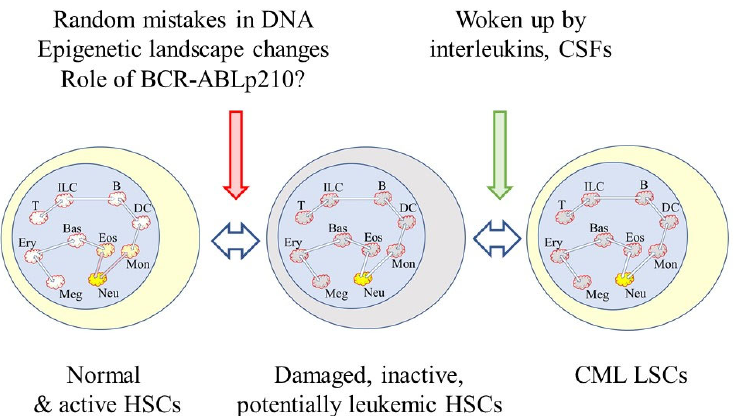
Figure 3. Waking up of damaged cells that pre-exist. Damage to the normal HSC genome occurs from random mistakes during DNA replication, and BCR-ABLp210 is known to enhance DNA damage. The BCR-ABLp210 tyrosine kinase facilitates the repair of DNA double-strand breaks, but it has been proposed that there is genetic instability within CML cells due to the unfaithful repair of double stranded breaks. There are BCR-ABLp210-provoked changes to the epigenetic landscape. The damaged cells are apparently normal but potentially cancerous. They are inactive and woken up by signals received from the environment, perhaps from interleukins or colony stimulating factors